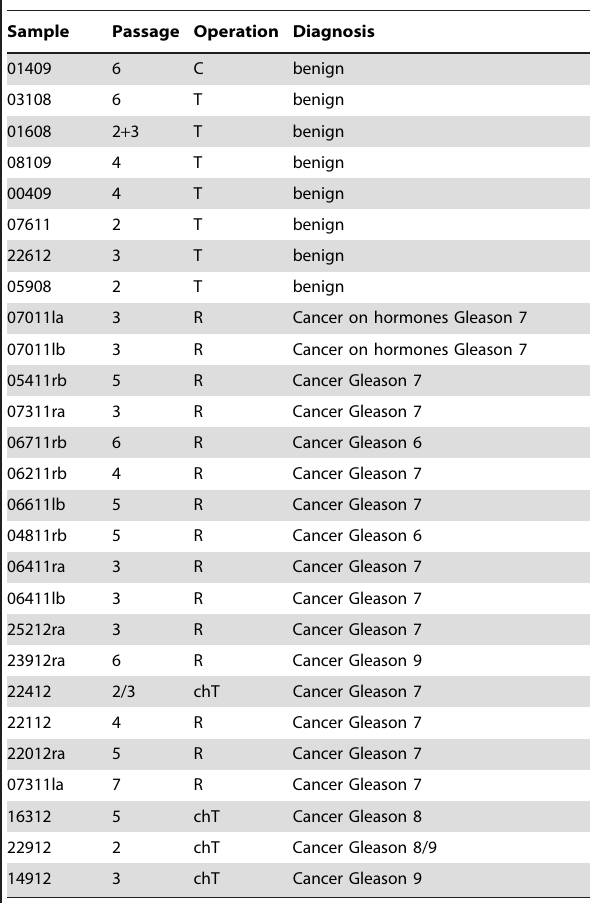
Table 2. Primary epithelial